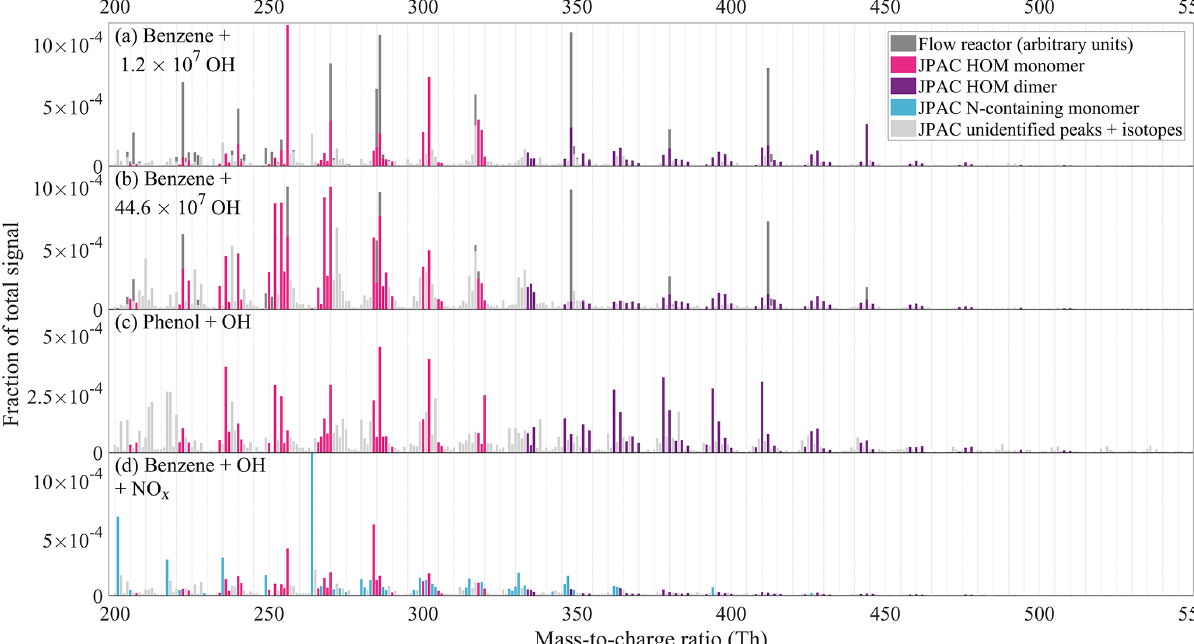
Figure 5. CI-APi-TOF spectra observed during experiments at JPAC. The y axis shows the signal normalised to total ion counts. Panel (a) shows the mass spectrum of benzene oxidation at the lowest OH concentration among our experiments, while panel (b) corresponds to the highest OH concentration. In panels (a) and (b) , the scaled flow reactor mass spectrum is also included for comparison (dark grey bars, in arbitrary units). Panel (c) shows the oxidation products of a phenol oxidation experiment. In panels (a) , (b) , and (c) , the colour schemes are identical and non-grey peaks represent those that were included in HOM yield calculation, with the exception of a few peaks. The full list of peaks is presented in the Supplement (Table S4). Panel (d) shows the benzene + OH experiment in presence of NO x , where N-containing ions (“N-containing monomers”) dominate the